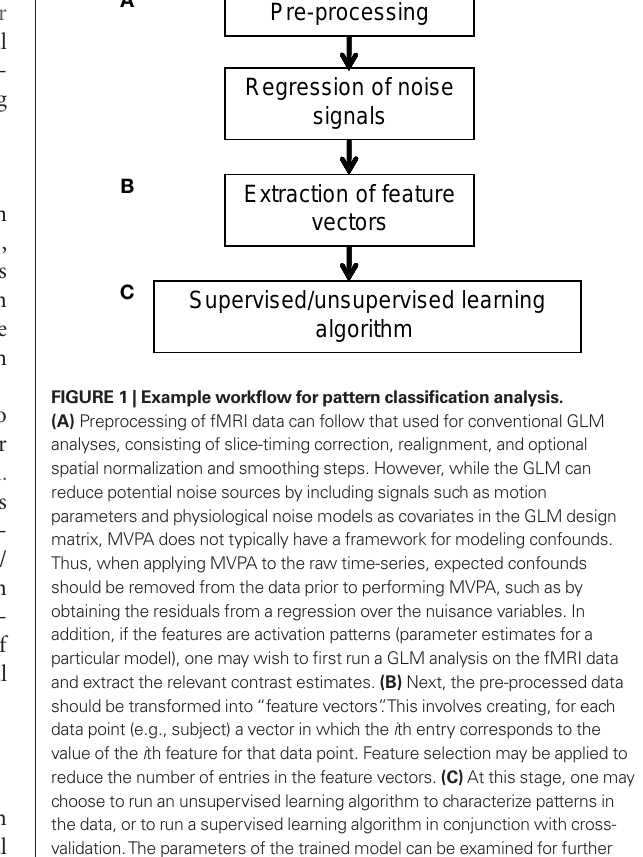
the data, or to run a supervised learning algorithm in conjunction with cross- validation. The parameters of the trained model can be examined for further insight, and the model may also be applied to make predictions on additional datasets so as to further explore its generalization ability.